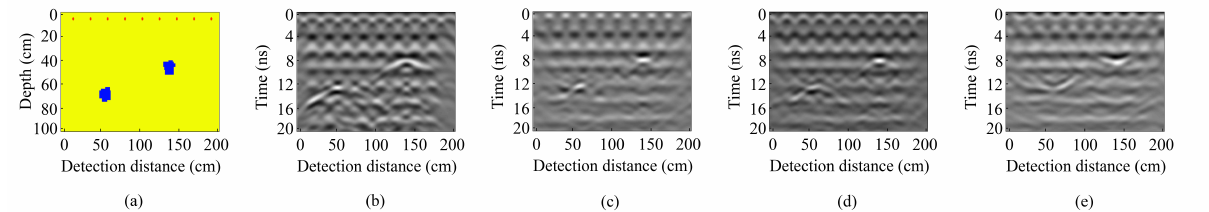
Figure 4. Stolt migration with different velocities: ( a ) permittivity map, ( b ) original B-scan GPR image, ( c ) migration with the correct velocity value (0.096 m/ns), ( d ) migration with a lower velocity value (0.080 m/ns), and ( e ) migration with a higher velocity value (0.140